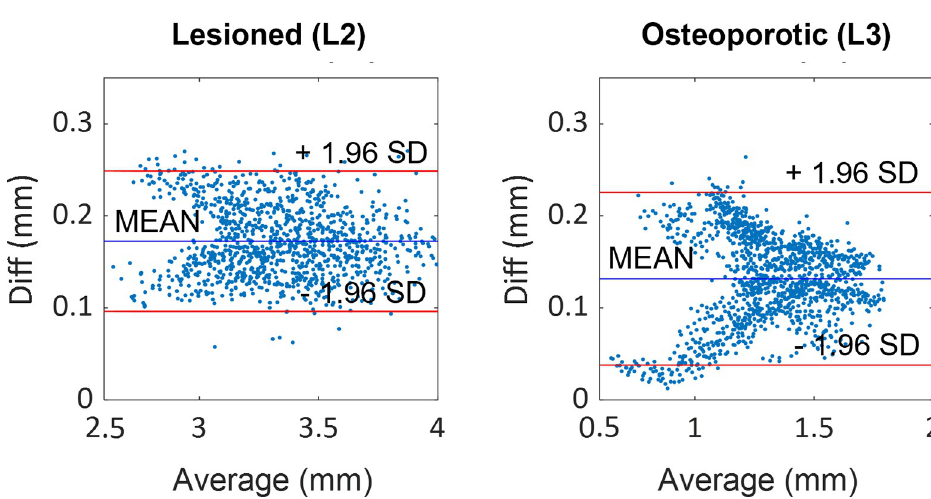
Fig 5. Residual analysis estimated between FE and DIC displacements. Bland-Altman plots showing the dependence of the vector sum magnitude (Diff) on the average value between measured and predicted local